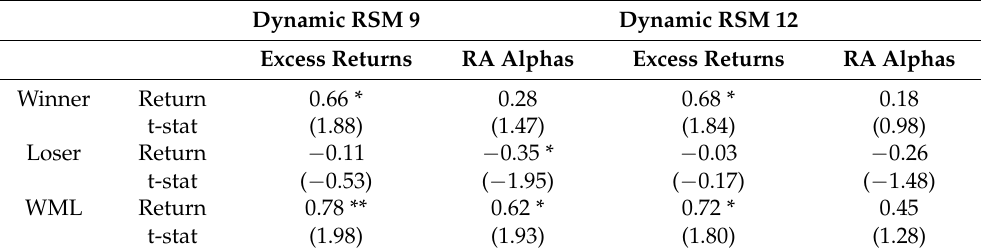
Table 4. Descriptive statistics of dynamic threshold return signal momentum and economic policy uncertainty. ** denotes 0.05 significance level, and * represents significant at 0.1 level,